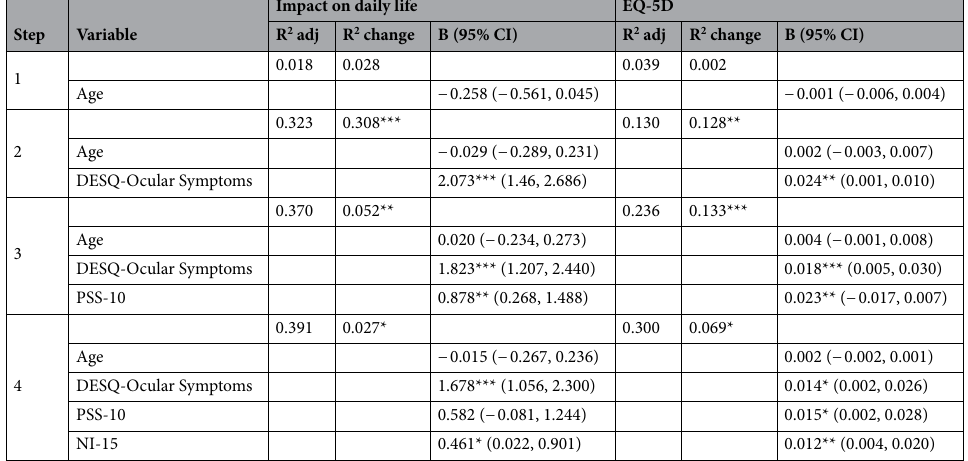
Table 3. Hierarchical multiple regression analyses predicting QOL score of DEQS-Th and EQ-5D from DEQS-Ocular symptoms, perceived stress, and neuroticism scores. QOL quality of life, DEQS‑Th Thai version of Dry Eye-related Quality-of-Life Score, EQ‑5D EuroQoL-5 dimension, adj adjusted, R coefficient r, R 2 adj adjusted R square, B unstandardized Coefficients, PSS Perceived Stress Scale, NI Neuroticism Inventory, *p < 0.05, **p < 0.01, ***p <